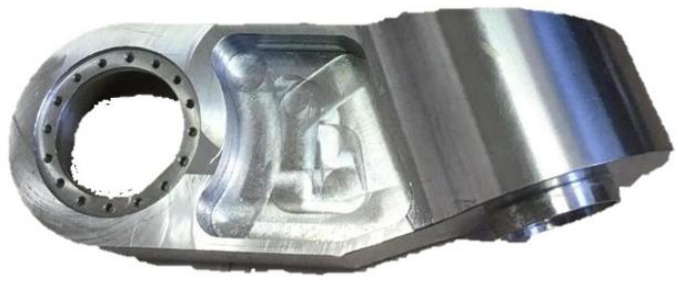
Table 2. Physical-mechanical properties according to EN573-3.